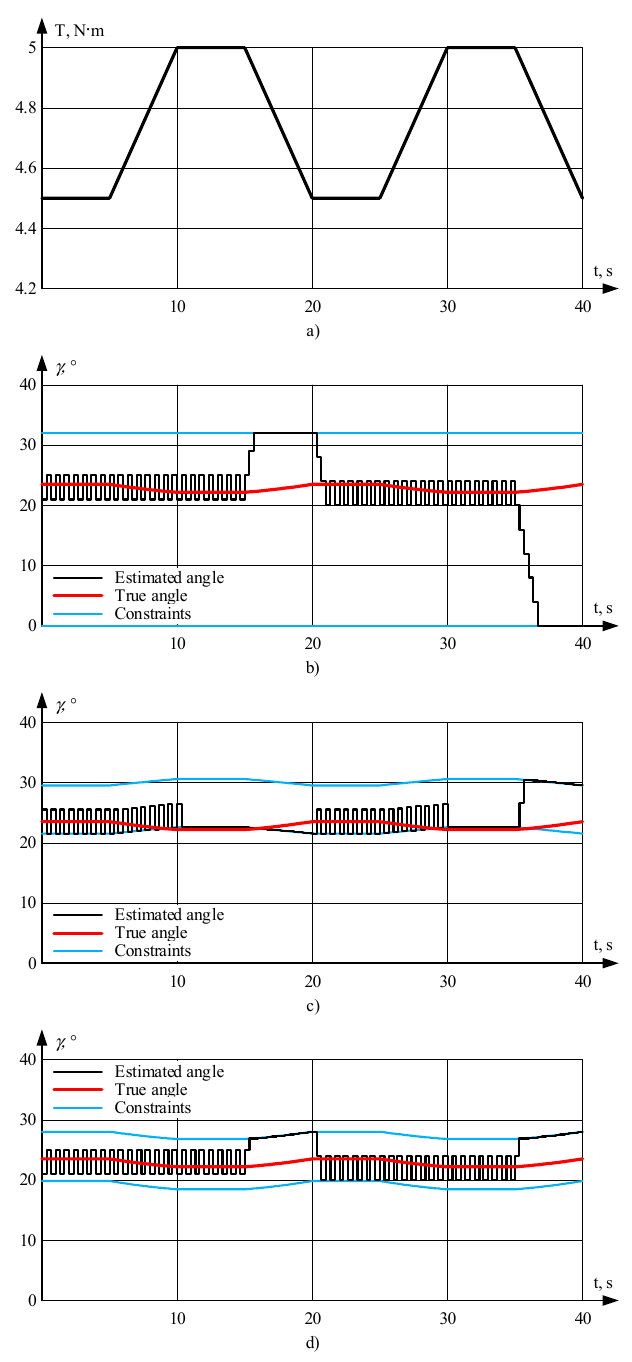
Figure 18. Operation of the seeking algorithm with different constraints at high load. ( a ) Torque profile; ( b ) Fixed limits; ( c ) Rated MTPA curve with gaps; and ( d ) Proposed technique.